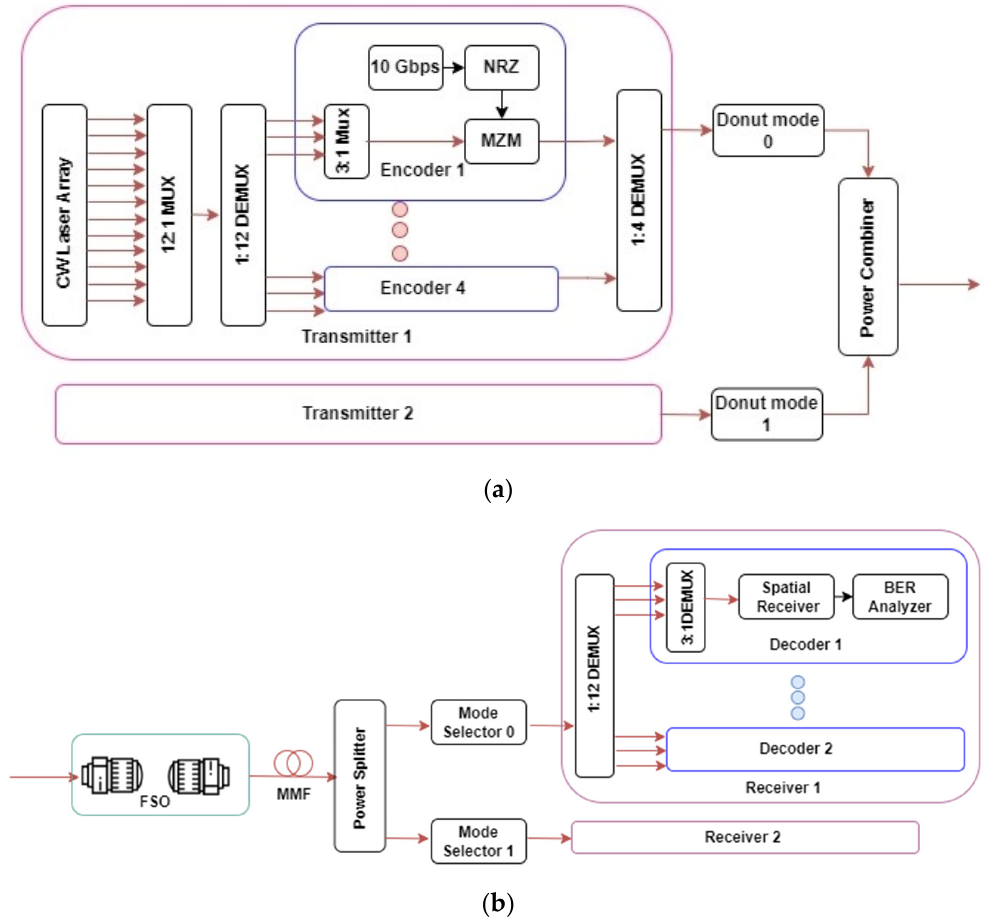
Figure 1. Proposed 8 × 10 Gbps OCDMA based MDM-FSO-MMF system of ( a ) transmitter, ( b ) receiver.